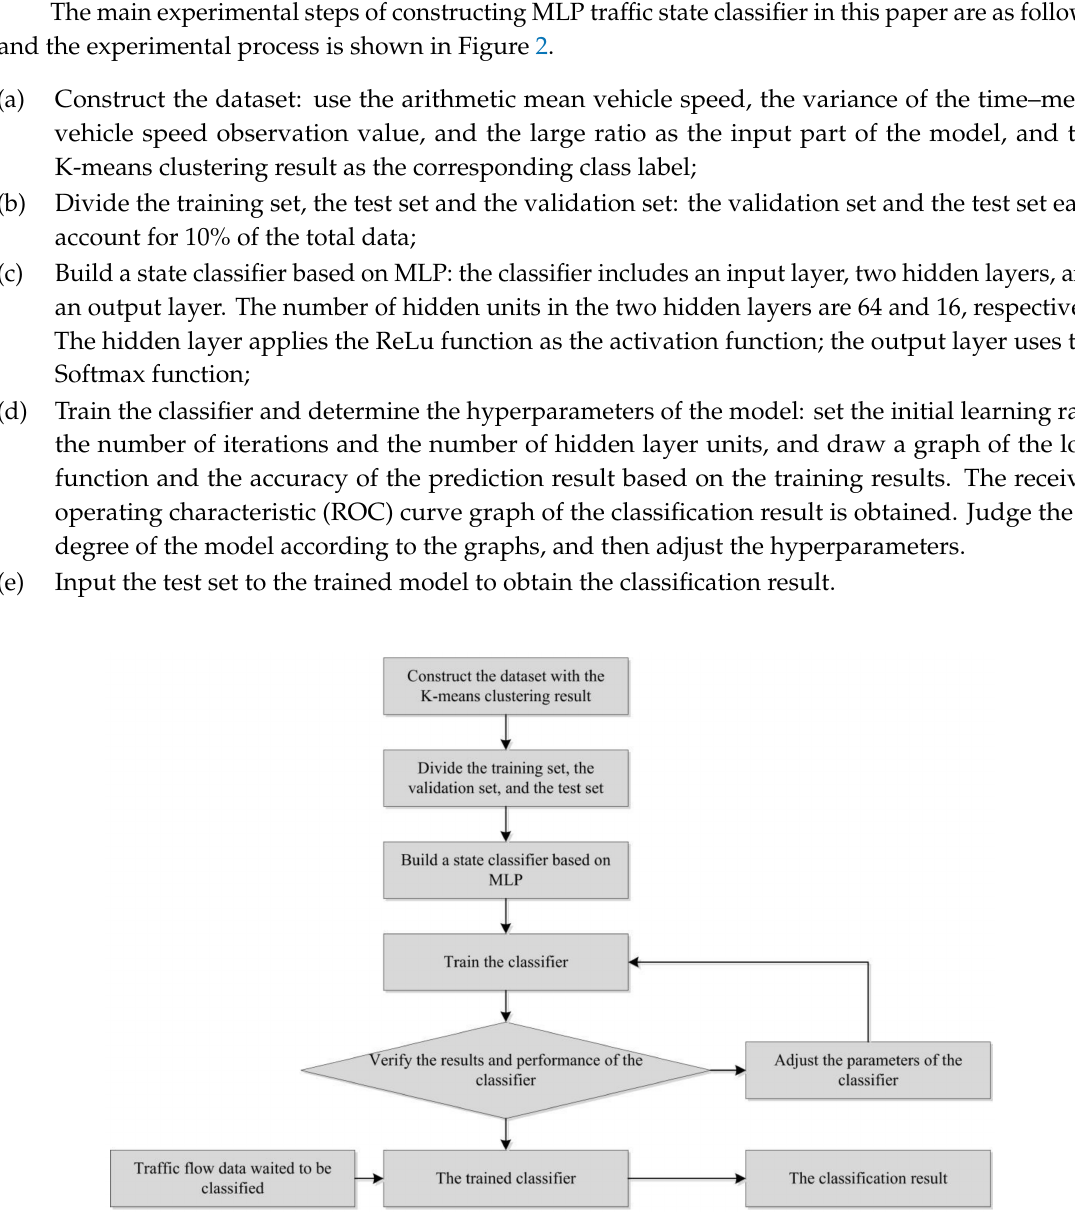
Figure 2. The experiment process of tra ffi c state